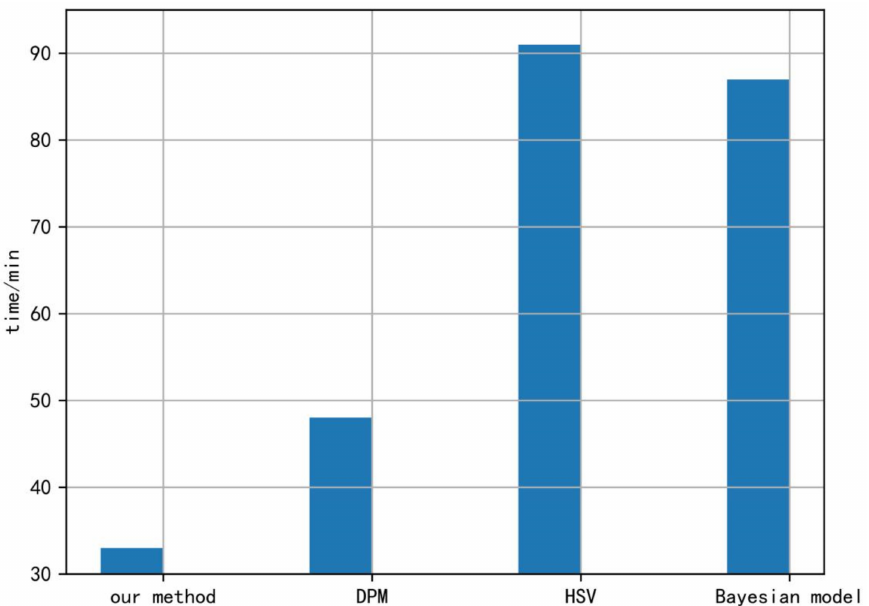
Figure 9. Running times of the Bayesian attention model, DPM model, skin-color-based HSV model, and the proposed framework.